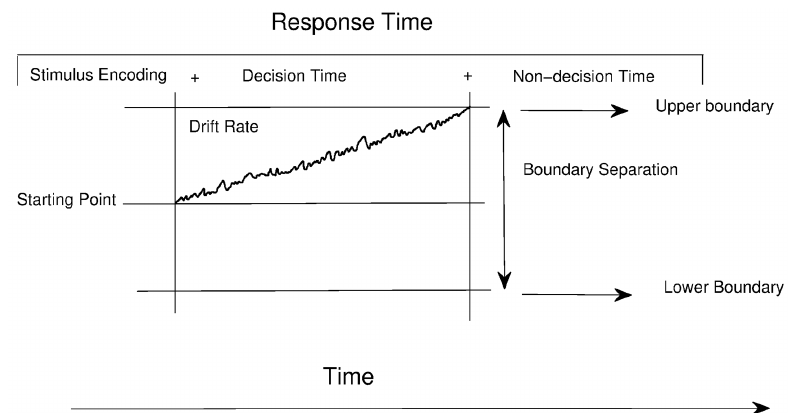
Figure 1. Graphical representation of the